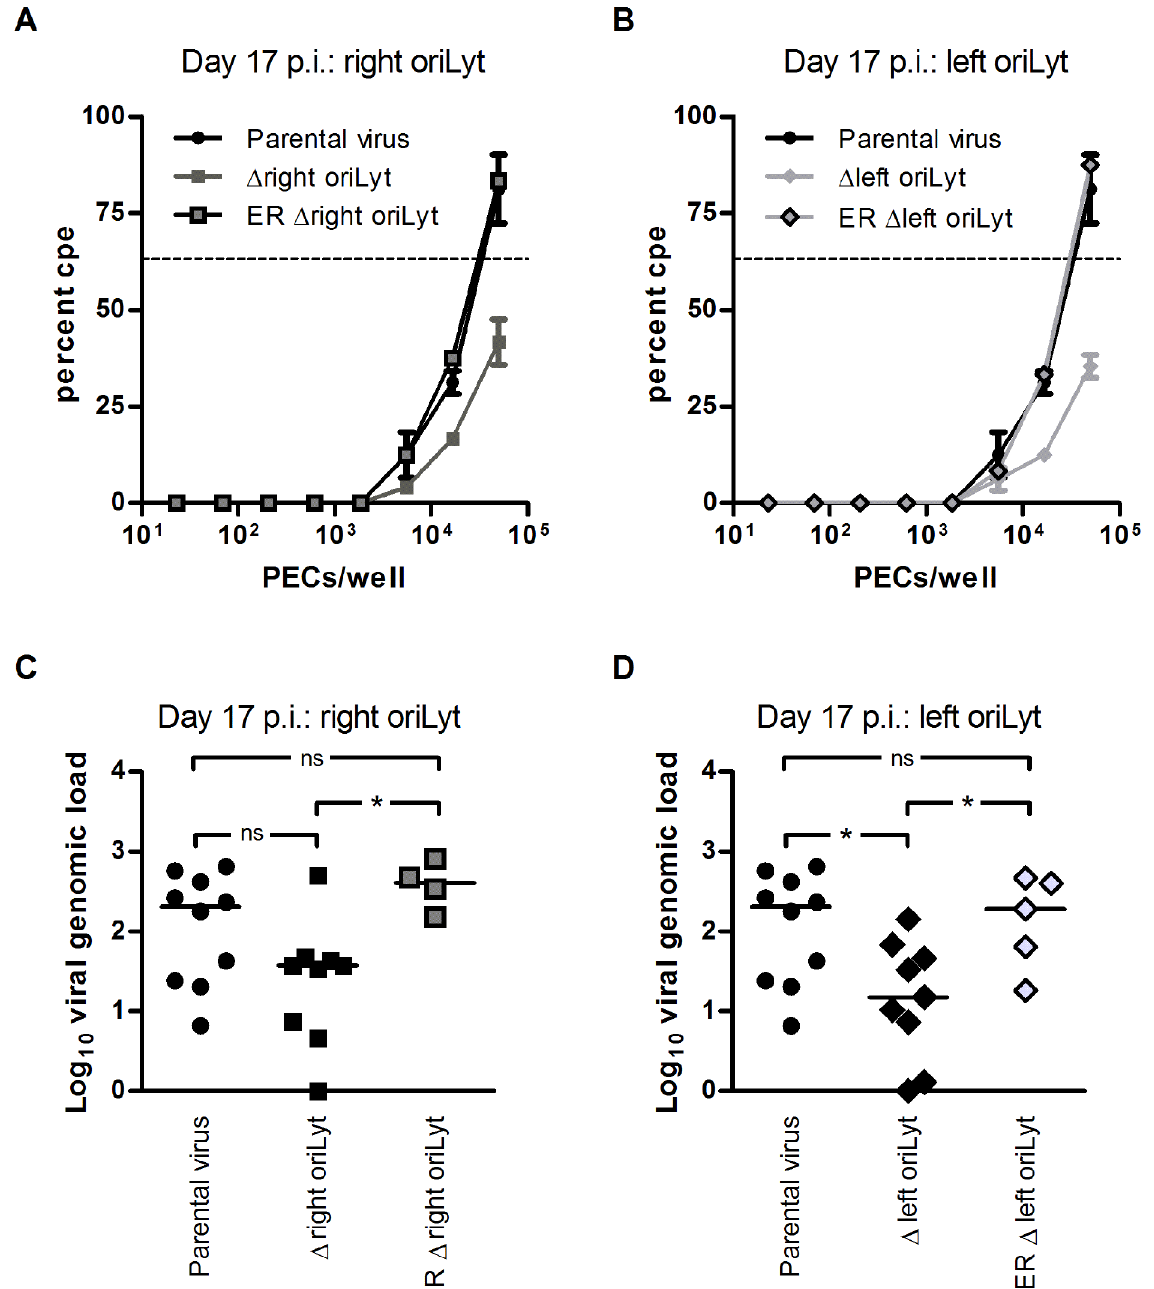
Fig 4. Latent infection in PECs after i.p. inoculation. C57BL/6 mice were inoculated i.p. with 1x 10 4 PFU of the indicated viruses. PECs were harvested at day 17 after infection to analyze latent infection in the ex vivo reactivation assay (A and B) or for DNA isolation and real-time PCR analysis of the viral genomic load (C and D). Data for parental virus and virus mutants are obtained from two independent experiments, each with five mice per group. Data for the ectopic revertants (ER Δ right oriLyt and ER Δ left oriLyt) are obtained from a single experiment with five mice per group. For the ex vivo reactivation assay, cells from five mice per group were pooled in each experiment and data shown are the means ± SEM (parental virus or virus mutants) or values from a single experiment (ectopic revertants). The dashed line indicates the point of 63.2% Poisson distribution, determined by nonlinear regression, which was used to calculate the frequency of cells reactivating lytic replication. In panels C and D, each symbol represents an individual mouse, and the bars represent the median value. Asterisks indicate a statistically significant difference between the groups ( * P < 0.05).